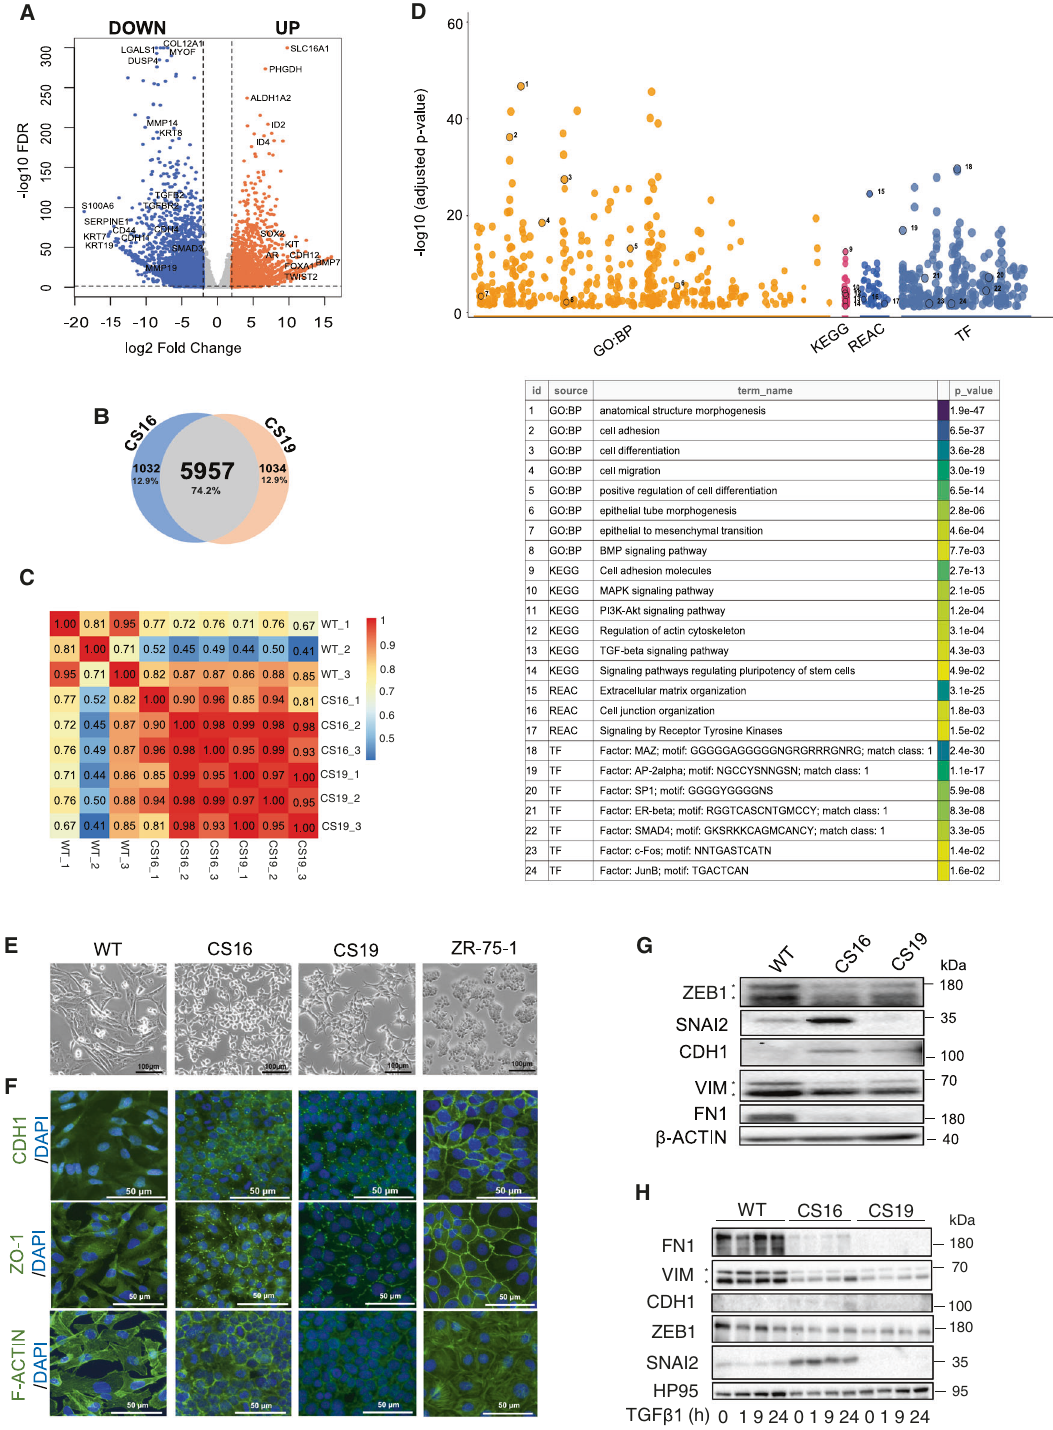
neural network-based nnet package in R. TCGA samples ( n = 945) formed a training ( n = 609) and a validation set ( n = 336), before testing the multivariate model in the training set, and investigating the predictive power of the model in the validation set. Statistical signi fi cance of the variables was based on a two-tailed Z test and a confusion matrix assessed performance of the model. For binomial logistic regression analysis, we classi fi ed TCGA samples into basal and non-basal tumors, and implemen- ted a generalized linear model to fi t the data in R. Statistical signi fi cance of